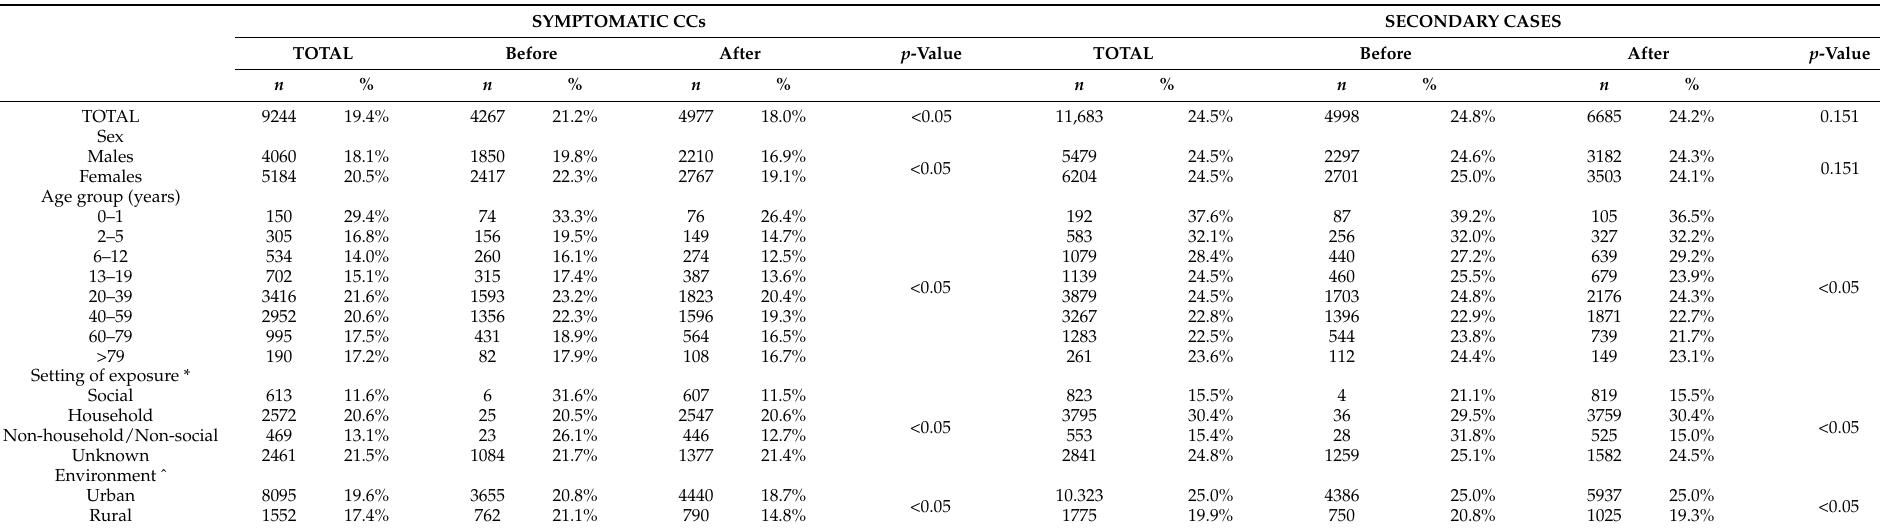
Table 1. Demographic characteristics of symptomatic close contacts (CCs) and secondary cases before and after the Universal PCR